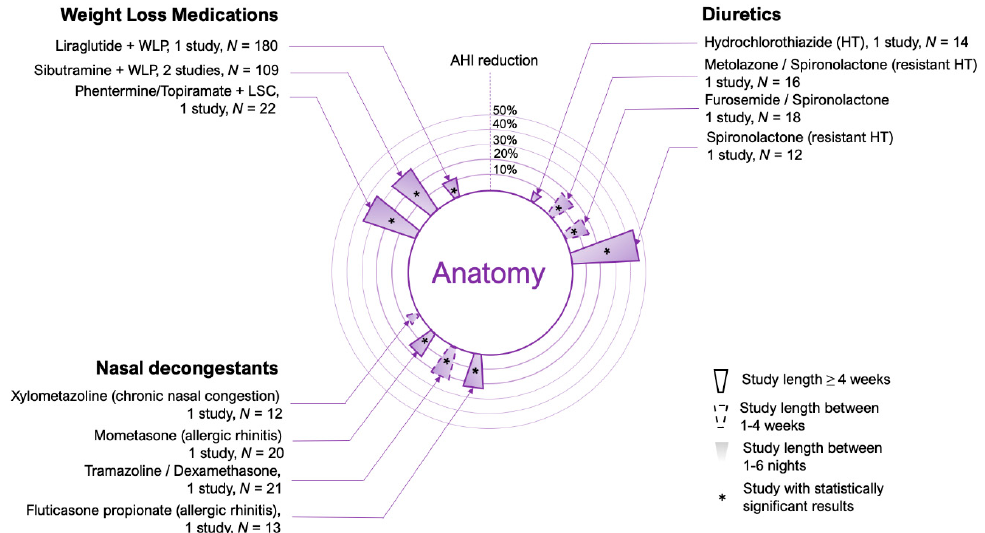
Figure 2. Circular bar plot describing the studies performed using medications that modify anatomic traits in OSA patients. Only observational studies and clinical trials in which the apnea-hypopnea index (AHI) or the respiratory disturbance index (RDI) was reported were considered. No case reports or case series were included. AHI reduction refers to percent change from placebo values (or baseline when placebo was not available). Data represents a weighted average of AHI reductions if more than one study was testing the same medication(s). Study length (see legend) refers to the longest study performed using a particular medication. Every asterisk represents one single significant study. See text for specific di ff erences and details of the studies considered. HT: